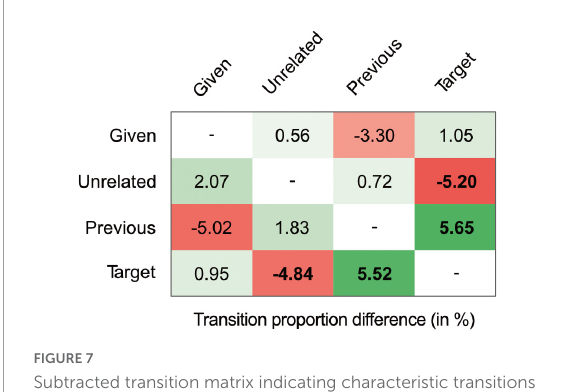
FIGURE7 Subtracted transition matrix indicating characteristic transitions regarding the construction of productive (green cells) and unproductive drawings (red cells); significant differences in transition types are displayed in bold ( p -value of <